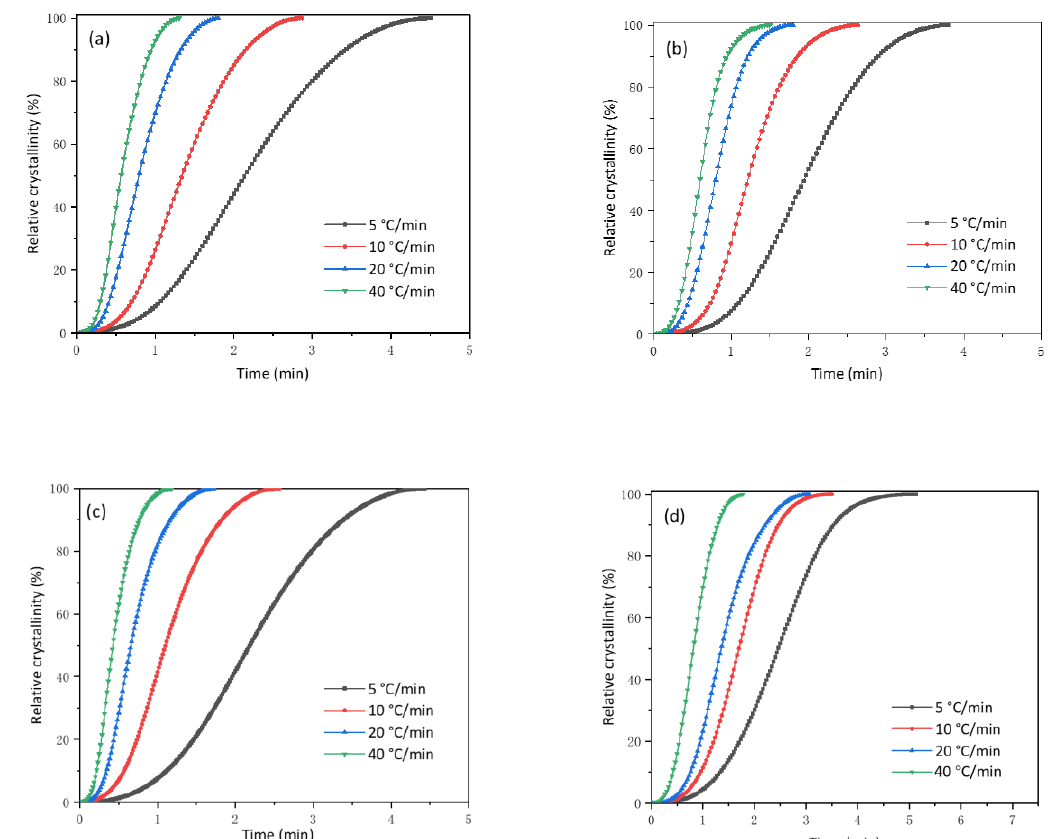
Figure 10. Relative crystallinity of TPAE-1000 ( a ), TPAE-1500 ( b ), TPAE-2000 ( c ) and PA10T/10I ( d ) as a function of time at different cooling rates.